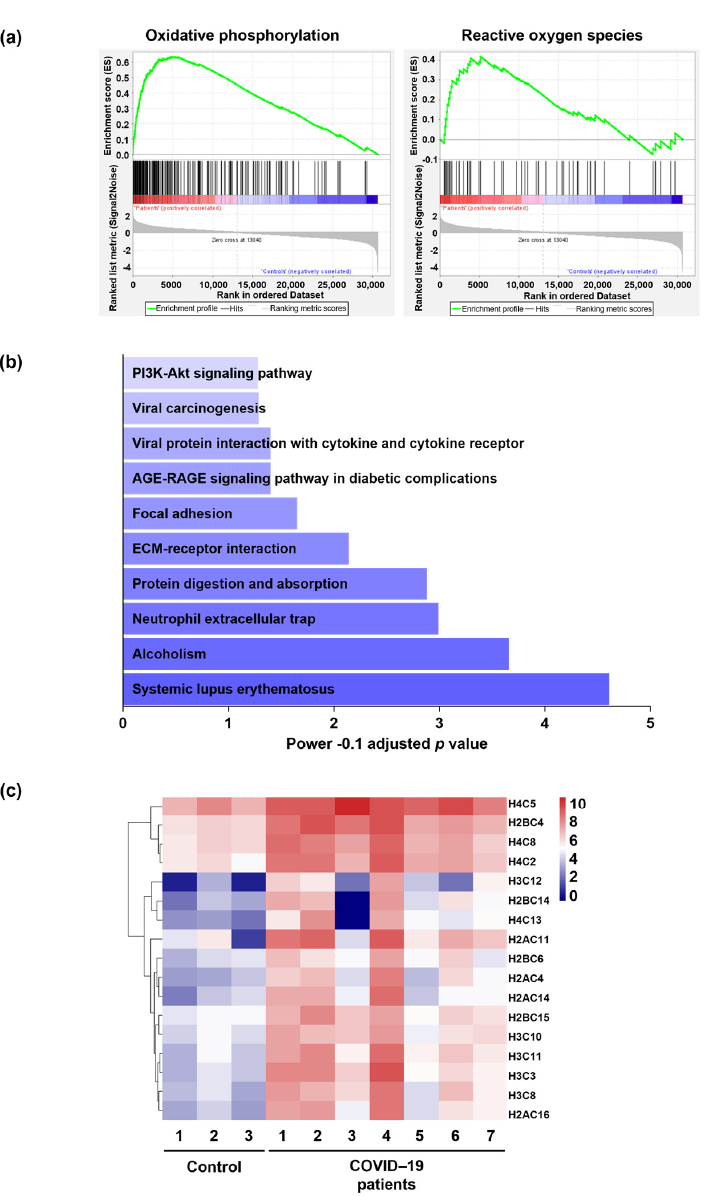
Figure 2. Analysis of enriched pathways. ( a ) Oxidative phosphorylation and ROS pathways were among enriched signaling pathways with a normalized p value < 0.001 in COVID–19 patients versus control lung tissues. Enrichment analysis was performed with the hallmark gene set collection based on ranked lists of all available genes by GSEA. The most enriched pathway is shown at the bottom of the graph, with a higher normalized enrichment score. ( b ) Top 10 enriched pathways in COVID–19 patients compared to control donors’ lung tissues based on Enrichr database. ( c ) Up-regulated genes (adjusted p value < 0.05 and log 2–fold change > 2) involved in NET formation depicted by heatmap in COVID–19 patients ( n = 7) compared to control lung tissues ( n = 3). The red color denotes higher, and the blue color indicates lower gene expression